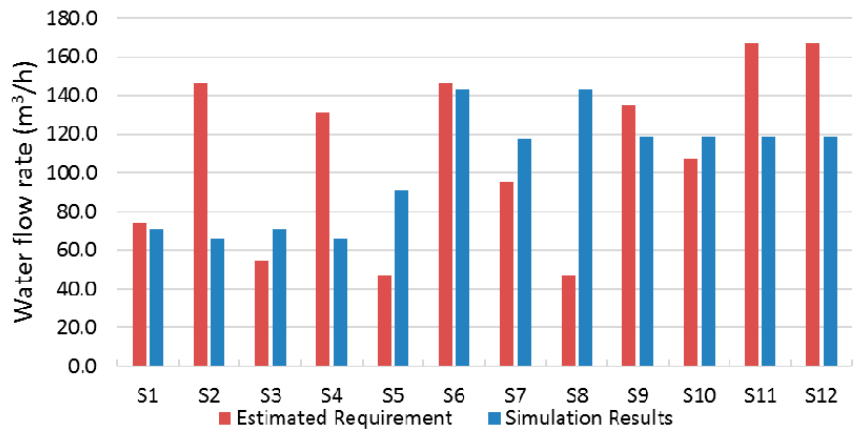
Figure 6. Water flow rate in each end use at 15:00.